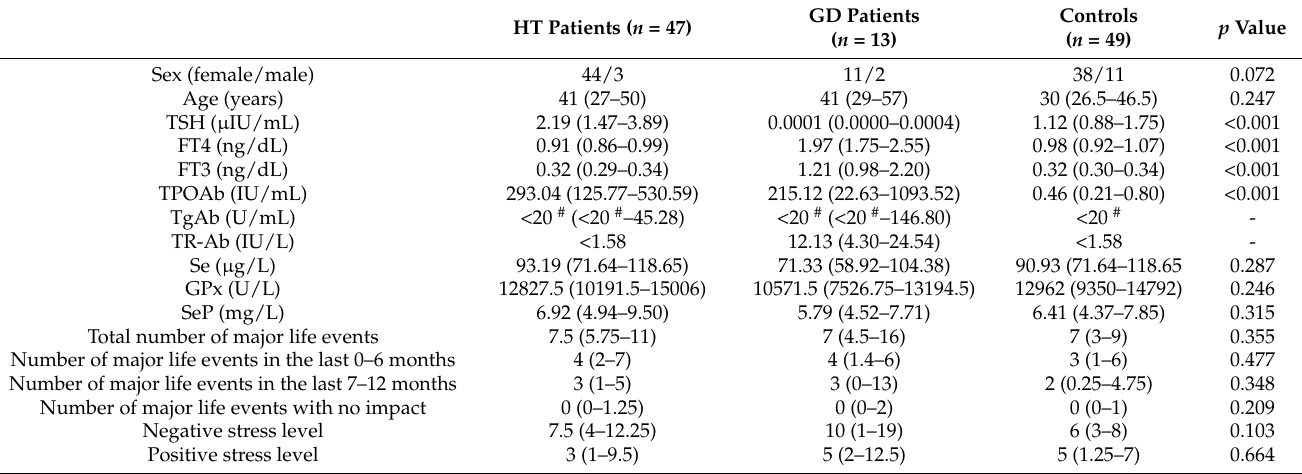
Table 1. Demographic and biochemical characteristics of the study groups. Numerical data presented as median (interquartile